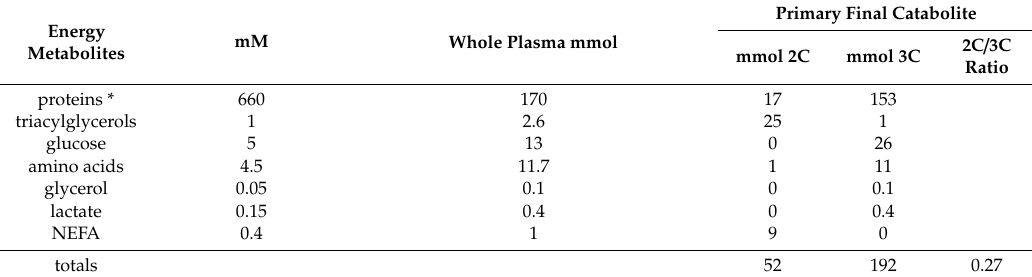
B—Whole-body plasma metabolite and energy content equivalents of adult healthy men †